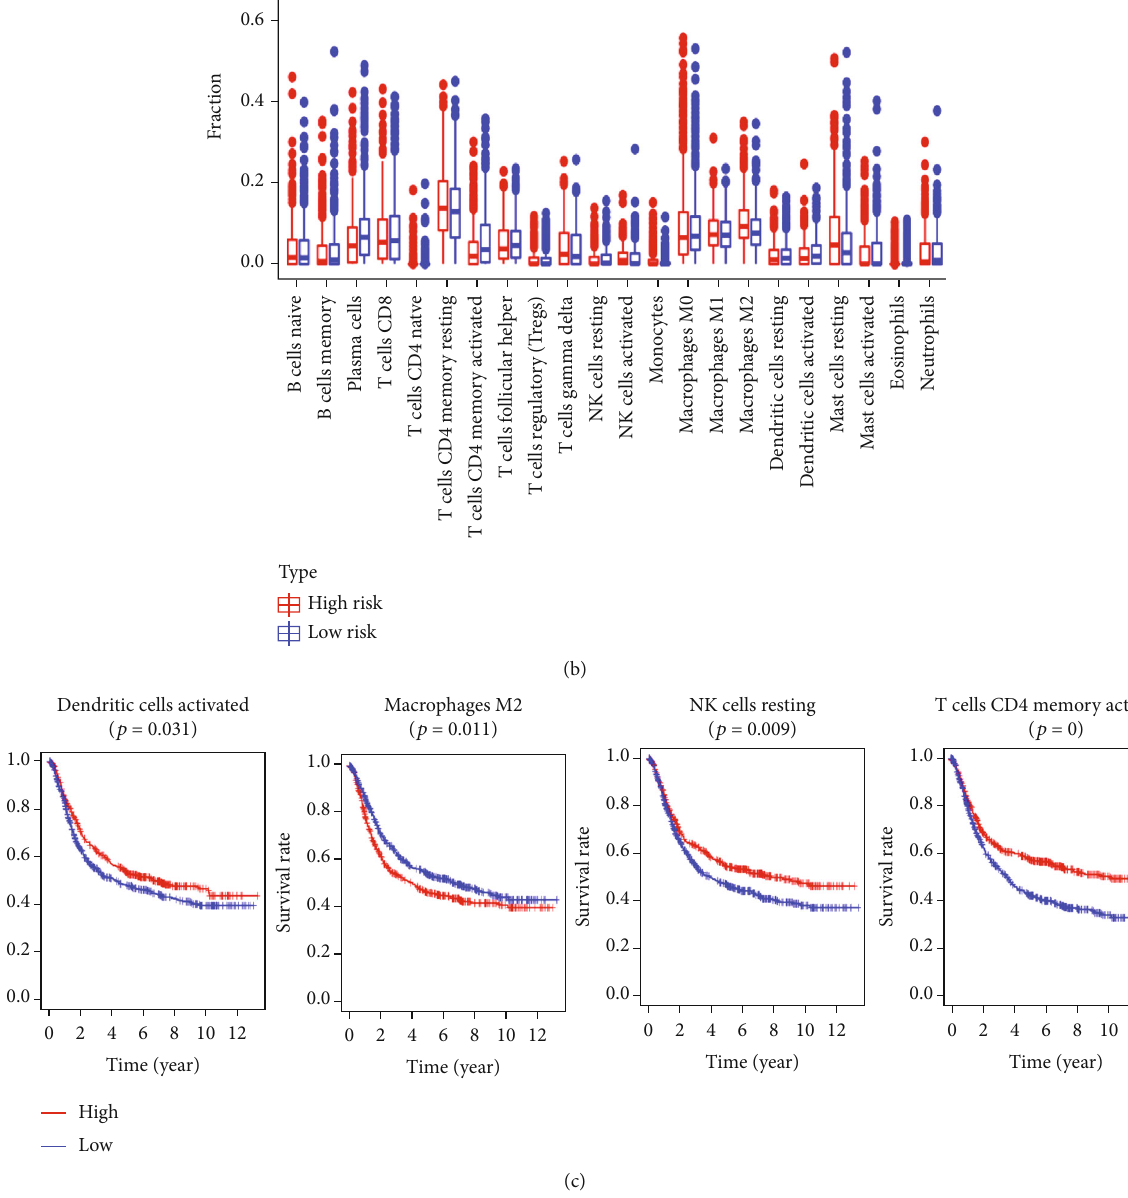
Figure 6: The immune cell in fi ltration landscape of all included samples. (a, b) Heatmap and the boxplot showing the di ff erence in immune cell in fi ltration in di ff erent risk groups. (c) Kaplan – Meier survival analysis regarding immune cell in fi ltration and